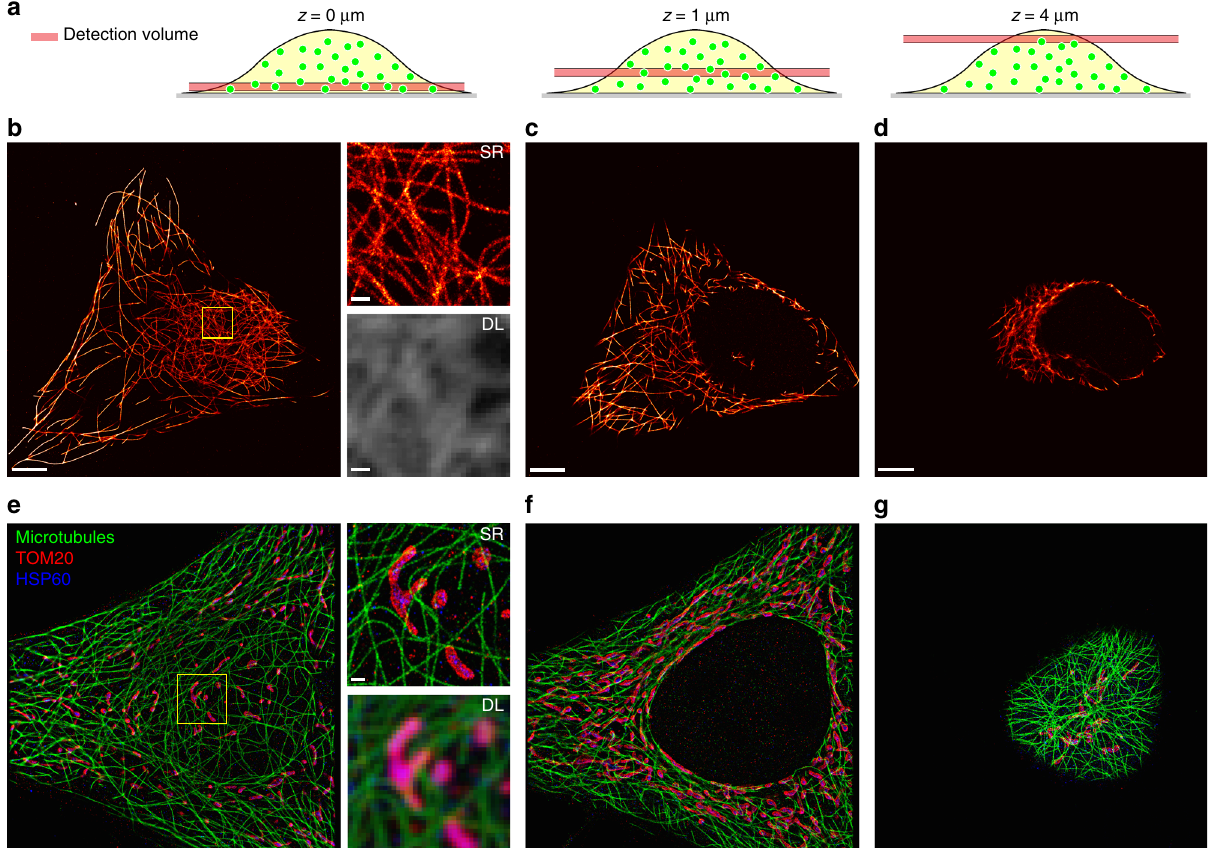
Fig. 2 Whole-cell DNA- and Exchange-PAINT enabled by SDC microscopy. a Schematic drawing of the cell and the detection volume for z positions 0 µ m (left), 1 µ m (middle), and 4 µ m (right). b 500-nm slice of the microtubule network in a HeLa cell at the coverslip surface. Left: super-resolved DNA-PAINT image. Right: super-resolved (SR) and diffraction-limited (DL) zoomed-in image of the highlighted area. c 500-nm slice of the same cell ~1 µ m away from the coverslip surface. d 500 nm slice of the same cell ~4 µ m away from the coverslip surface. e – g Three-target Exchange-PAINT of Alpha-Tubulin (green), TOM20 (red), and HSP60 (blue). e Left: DNA-PAINT super-resolution image of a 500-nm slice at the coverslip surface. Right: super-resolved (SR) and diffraction-limited (DL) zoomed-in image of the highlighted area. f 500 nm slice of the same cell ~1 µ m away from the coverslip surface. g 500-nm slice of the same cell ~4 µ m away from the coverslip surface. Scale bars, 5 µ m ( b – g ), 500 nm (insets in b and e